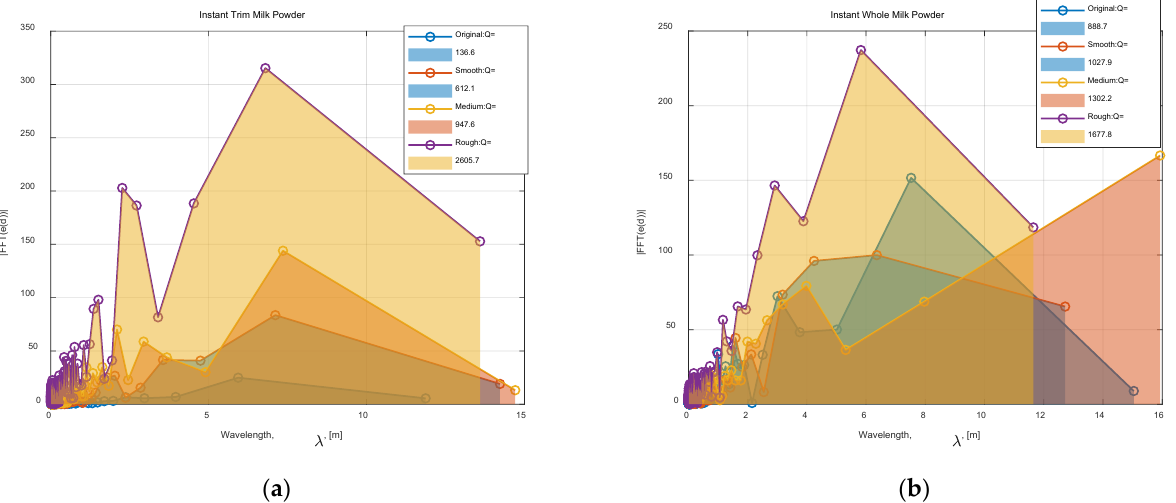
Figure 14. ( a ) Comparing the frequency response of the Class 0 – 3 instant trim samples; ( b ) comparing the frequency response of the Class 0 – 3 instant whole samples.